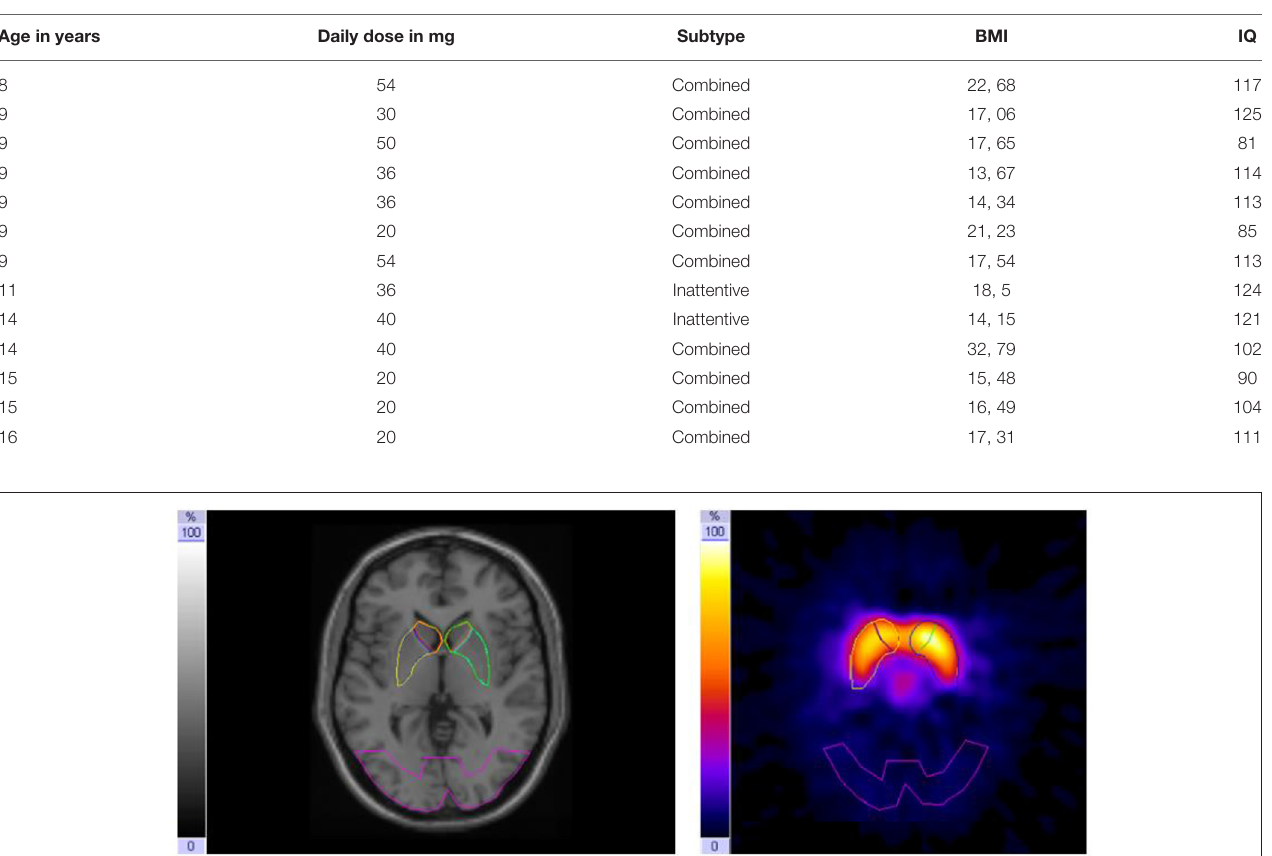
TABLE 1 | Sample characteristics.